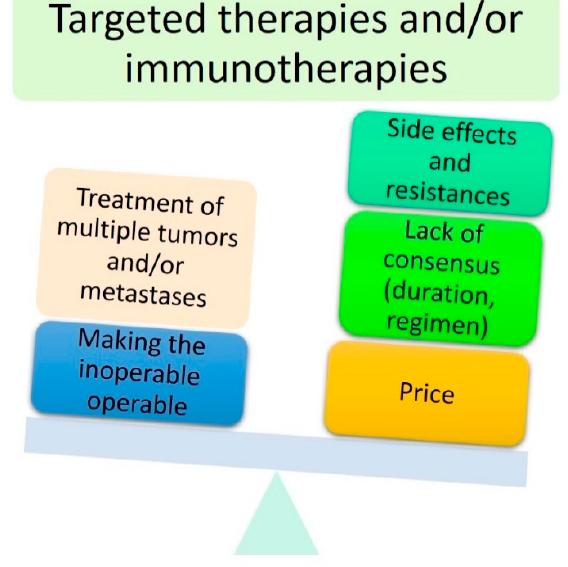
Figure 8. Main advantages and disadvantages of targeted therapies and immunotherapies.